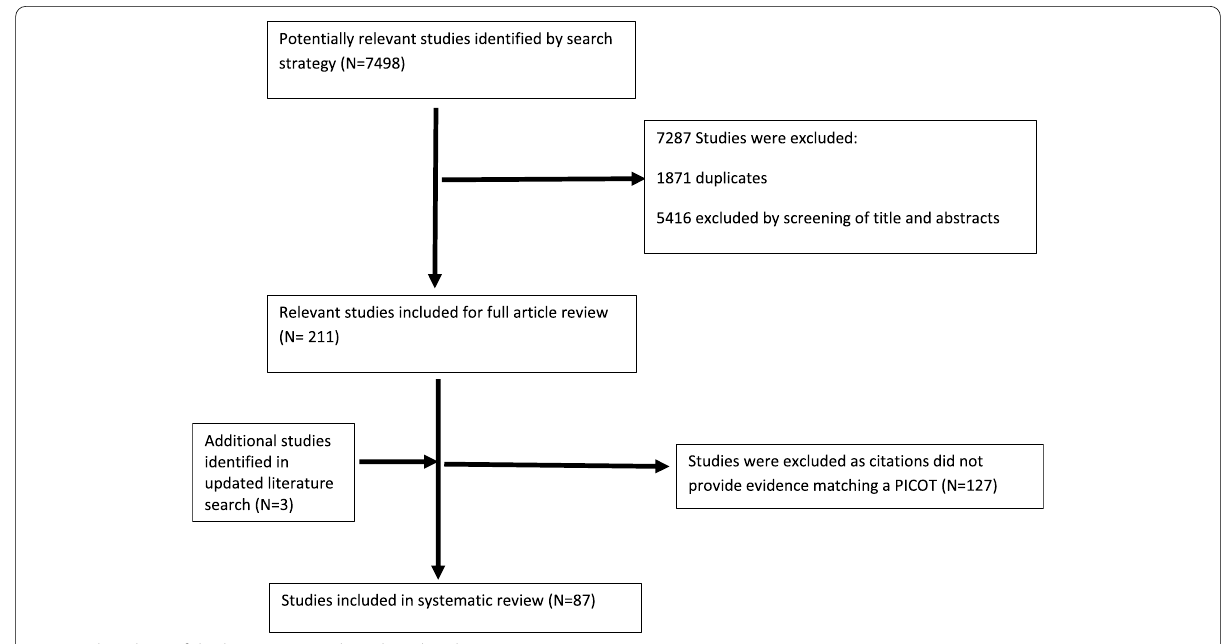
Fig. 1 Flowchart of the literature search and study selection process